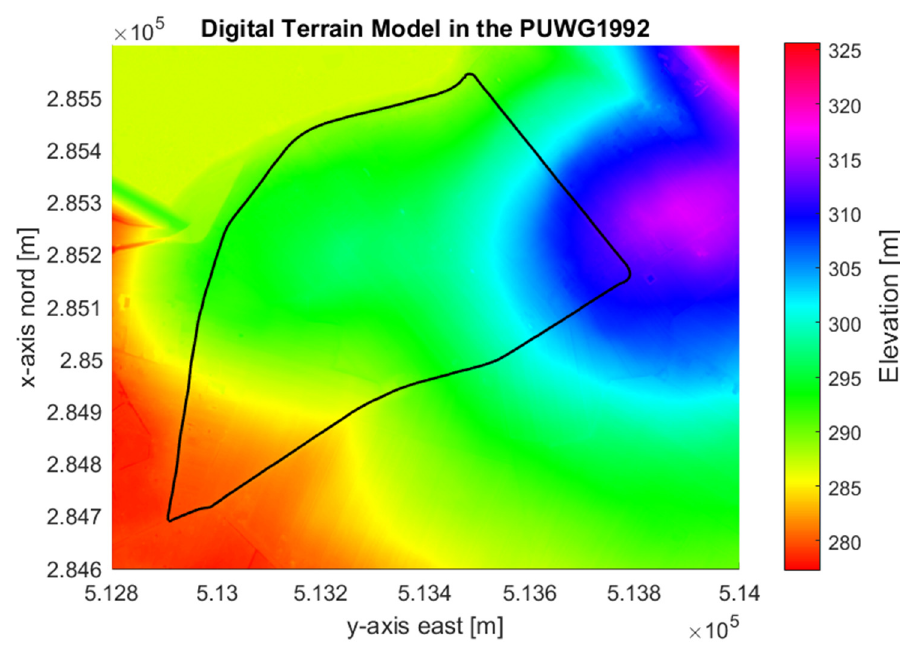
Figure 14. Averaged path on the height map background.